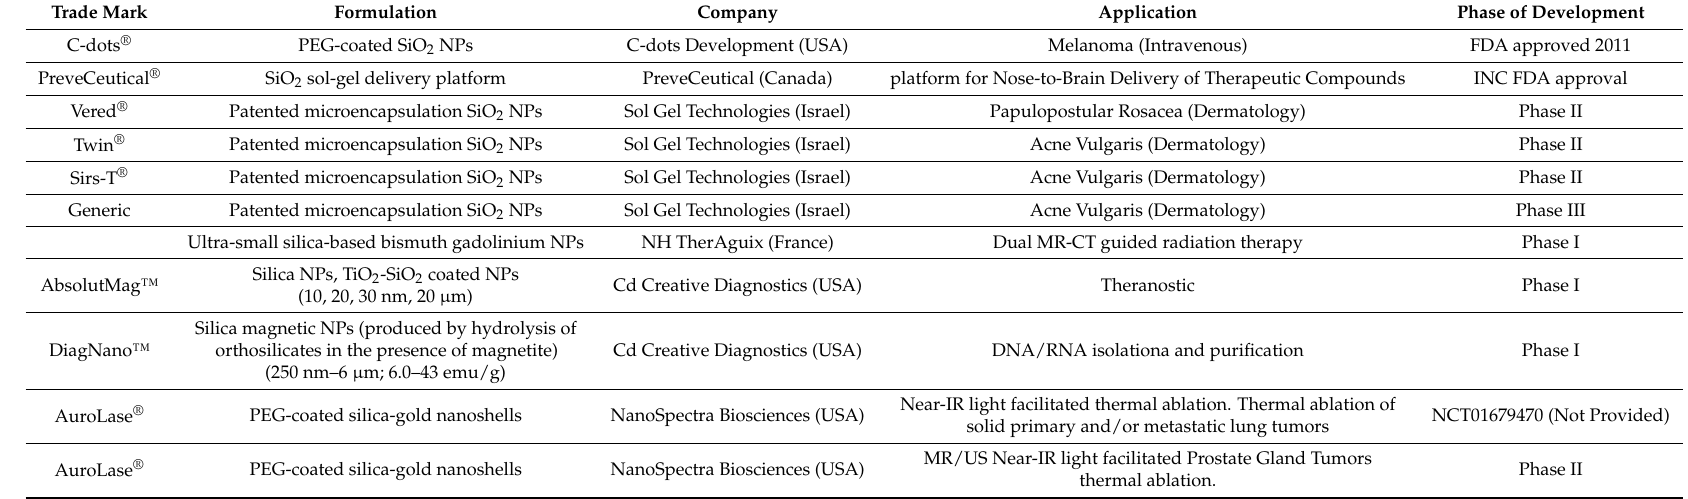
Table 2. Sol-gel silica nanocarriers in clinical use and under clinical